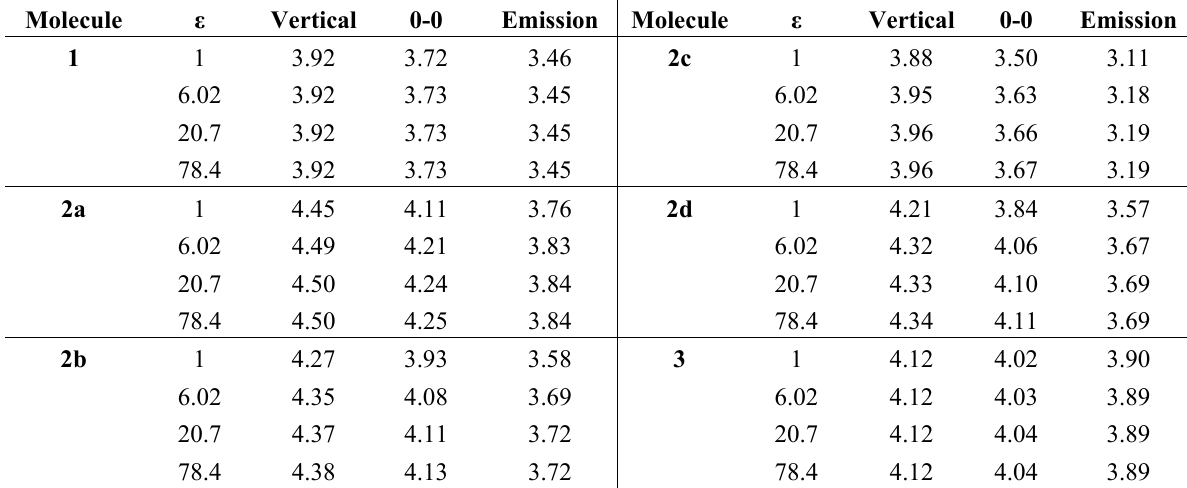
Table 1. Franck-Condon vertical excitation, 0-0 and emission energies calculated using LRC- ω PBE/6-31G(d) in the gas phase and solvated using the PCM model. All energies in eV. Molecule